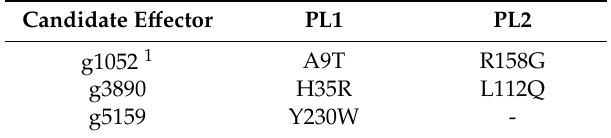
Table 2. Polymorphic loci positions in candidate e ff ectors (CE) proteins.